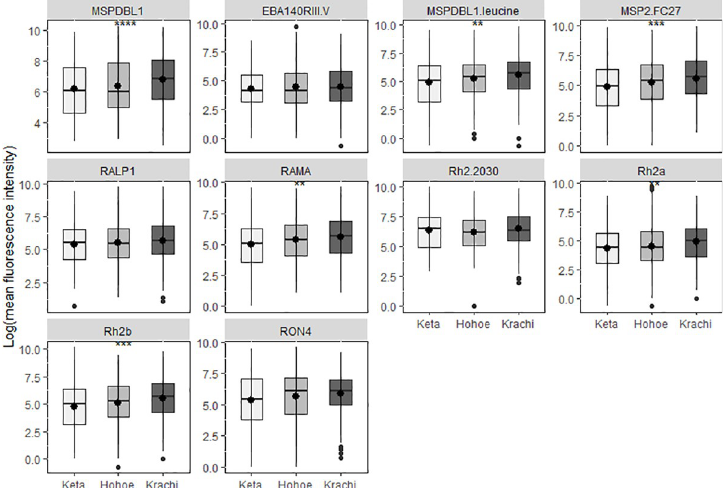
Fig 4. Total IgG levels to multiple malaria antigens in the three districts. Box and whisker plots with a round dot in the middle, the median IgG level of the group. Difference in antibody levels between the districts are shown for each antigen tested. The x-axis represents the districts ( �� p < 0.01, ��� p < 0.001, ���� p <